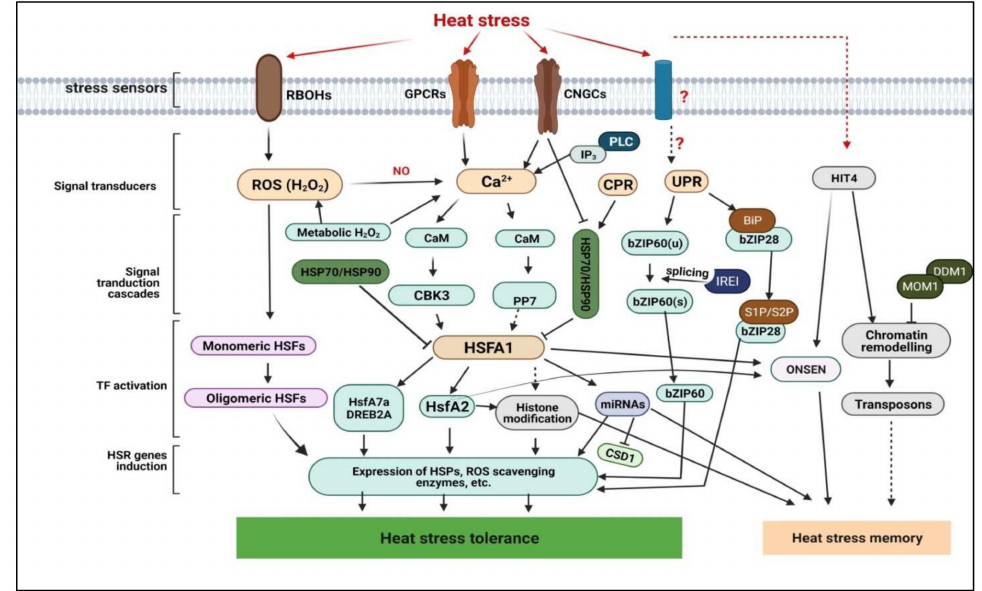
Figure 1. Molecular regulatory networks underpinning plant HS response and HS memory. HS alters plasma membrane (PM) fluidity, thereby initiating a lipid signalling pathway and inducting Ca 2+ channels. Other PM-embedded receptors, such as the CNGCs, RBOHs, etc., perceive HS sig- nals. Elevated cytosolic Ca 2+ ions evoke the Ca 2+ signalling pathways, mediated by the calmodulins (CaMs), CBKs or CDPKs (see text for details). The CaM interacts with CBK3 and CaM-binding protein phosphatase 7 (PP7) to activate HSFA1 by phosphorylation and enhanced regulation, respectively. The HSFA1 regulates the induction of several other HSFs, including HSFA2, dehydration-responsive element-binding 2A (DREB2A), HSFA7s, and micro-RNAs (miRNAs, e.g., miR398) that initiate the expression of HSPs and other heat stress-inducible genes, which eventually orchestrates physio- logical responses precipitating thermotolerance acquisition. Meanwhile, the ROS (H 2 O 2 ) sensed by the RBOHs, together with nitric oxide (NO) and metabolic H 2 0 2 generated from chloroplasts, mitochondria, etc., trigger ROS build-up, which initiates the ROS signalling pathway, and ultimately alters the expression of HSPs and other HS-inducible genes, via the activation of monomeric HSFs (inactive form in the cytoplasm), which yield oligomeric HSFs (active form which is translocated into the nucleus) to activate HSP gene expression. The PM-sensed HS signals, or ROS burst em- anating from the endoplasmic reticulum (ER)-generated HS also activate the cytoplasmic protein response (CPR) and unfolded protein response (UPR) mechanisms. The UPR network is largely mediated by the inositol-requiring protein-1 (IRE1)- bZIP60 mRNA and the site-1/site-2 proteases (S1P/S2P)-bZIP28 pathways. Upon ER stress, IRE1 catalyzes the splicing of the bZIP60 mRNA into a truncated bZIP60 (s) variant that encodes a bZIP60 protein lacking a transmembrane domain, which allows for its translocation from the ER into the nucleus, where it will activate HS-responsive genes expression. Under benign conditions, BiP (an ER-embedded chaperone) maintains b ZIP28 at the ER. However, ER stress causes the relocation of bZIP28 to the Golgi apparatus, where it undergoes proteolytic processing, consequently triggering nuclear relocation of its cytoplasm-facing domain, where it ultimately evokes HS-responsive genes expression. Meanwhile, histone modification (HM) and chromatin remodelling (CR) also stimulate HS-inducible gene expression. In addition, HM, CR, ONSEN and some transposons modulate plant HS memory (HSM). Heat-intolerant 4 ( HIT4 ) is a central regulator of CR in response to HS and facilitates nucleosome dispersion leading to the release of transcriptional gene silencing. HSFA2-derived HM offers transient HSM that lasts for a few days and facilitates rapid gene reactivation, whereas CR, ONSEN, and transposons-mediated HSM last for a longer period and provides long-term adaptation to plant HS. Note: Dashed lines and question marks signify links yet to be confirmed. Other abbreviations mentioned in the diagram: GPRCRs, G-protein coupled receptors; PLC, phospholipase C; IP3, inositol triphosphate; CSD1, copper/zinc superoxide dismutase 1 (CSD1); DDM1, DNA methylation 1; MOM1, Morpheus’ molecule